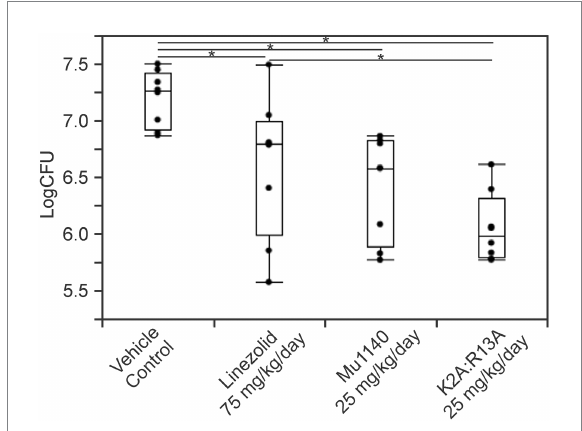
FIGURE 6 Bacteria load on the lesions of mice treated with linezolid and mutacins via subcutaneous injections in a subcutaneous MRSA skin infection. All treatments including vehicle control were given to the animals 48 h post-infection and lasted for 3 days. Significances (*) were observed between K2A:R13A and vehicle control (mean difference = 1.14, Cohen’s d = 2.64, value of p < 0.0001), Mu1140 and vehicle control (mean difference = 0.78, Cohen’s d = 1.80, value of p = 0.0012), linezolid and vehicle control (mean difference = 0.60, Cohen’s d = 1.39, value of p = 0.0097), and also between K2A:R13A and linezolid (mean difference = 0.54, Cohen’s d = 1.25, value of p = 0.0186). All groups had eight mice ( n = 8) and contained equal numbers of male and female